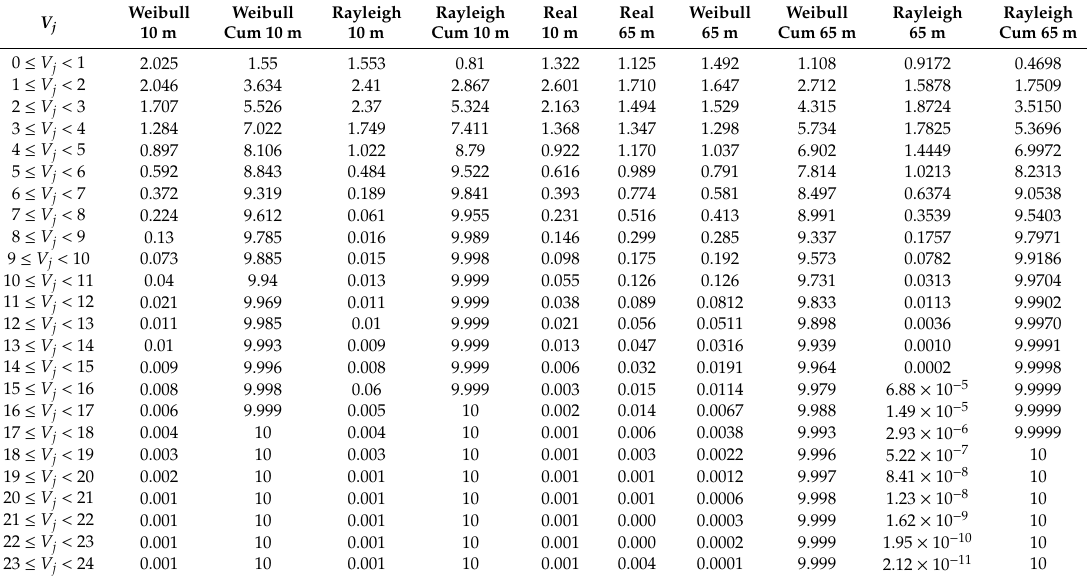
Figure 7. Comparison of the Weibull and Rayleigh distribution with real wind data at 10 m and 65 m hub height. Table 3. Weibull and Rayleigh frequency distribution compared with real data at 10 m and 65